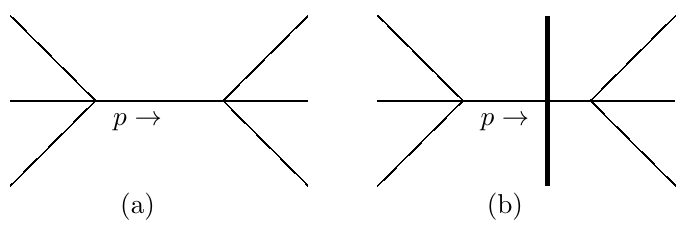
Figure 18 . (a) A tree diagram in (cid:30) 4 theory with six external lines and one internal propagator. In drawing this we have made an exception to our conventions and have drawn the external lines. The internal line has energy p 0 (cid:13)owing from the left to the right. (b) Cut diagram of (a).